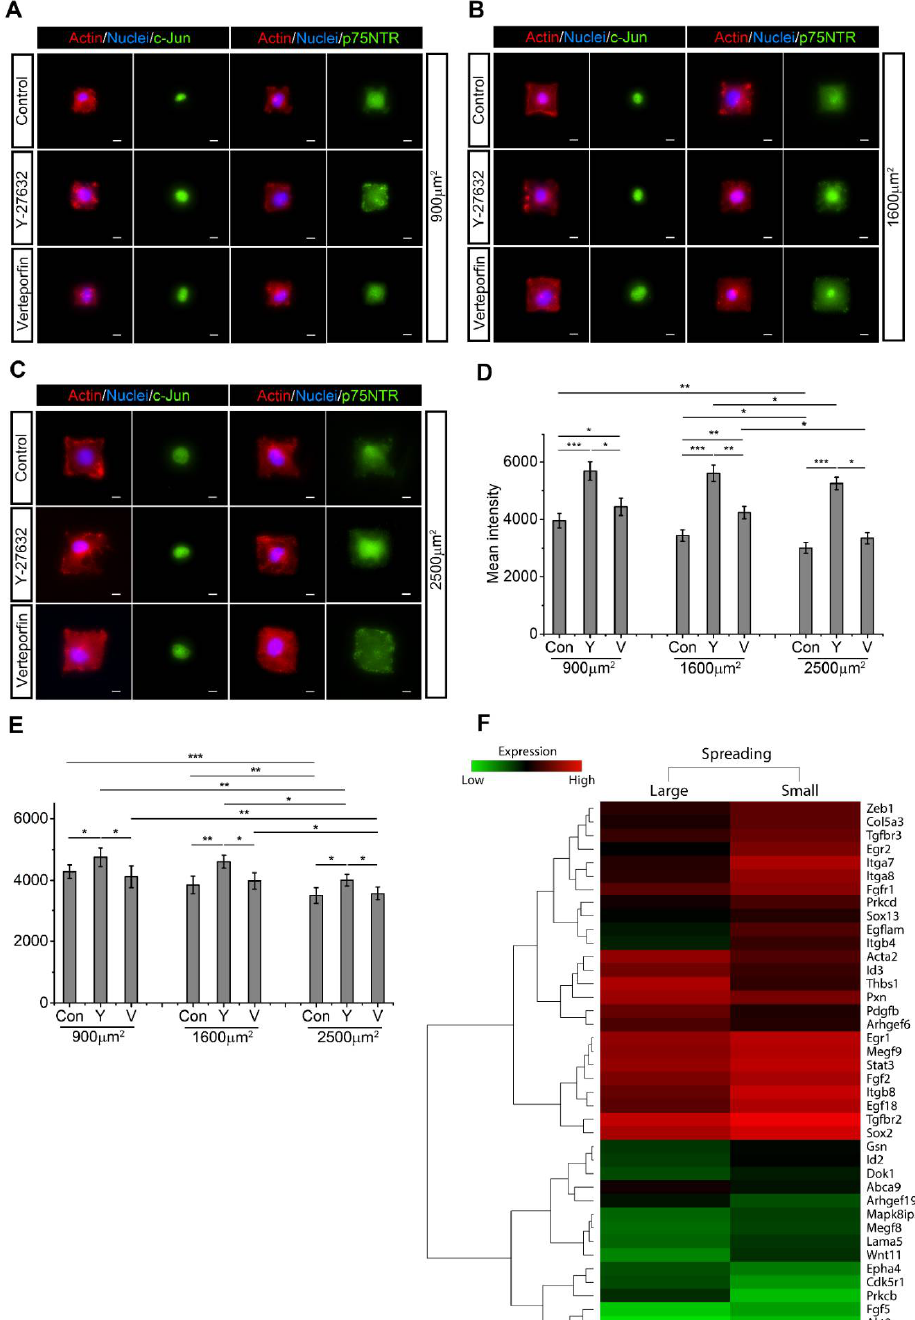
Figure 4. When cell spreading area remains constant, inhibition of RhoA and YAP/TAZ significantly upregulate the expression of c-Jun and p75NTR. Schwann cells (SCs) were seeded into ( A ) 900 µ m 2 , ( B ) 1600 µ m 2 , or ( C ) 2500 µ m 2 micropatterned cell adhesive islands. F-actin (red), nucleus (blue), c-Jun (green), and p75NTR (green) are visualized by immunofluorescence staining. Scale bar = 10 µ m. ( D , E ) Statistical analysis shows the expression of c-Jun and p75NTR after Y-27632 and Verteporfin treatment. Mean pixel fluorescent intensities are measured for quantification. For fluorescent intensity quantification of micropatterned SCs, 5 unique trials with a minimum of 51 single micropatterned SCs per trial were quantified. ( F ) Microarray analysis indicates that SC with larger spreading area showed higher RhoA- and YAP/TAZ- associated genes and a decline in SC regenerative markers. Data are presented as the mean ± SEM. * p < 0.05, ** p < 0.005, *** p < 0.0005, p -values found in Supplemental Table